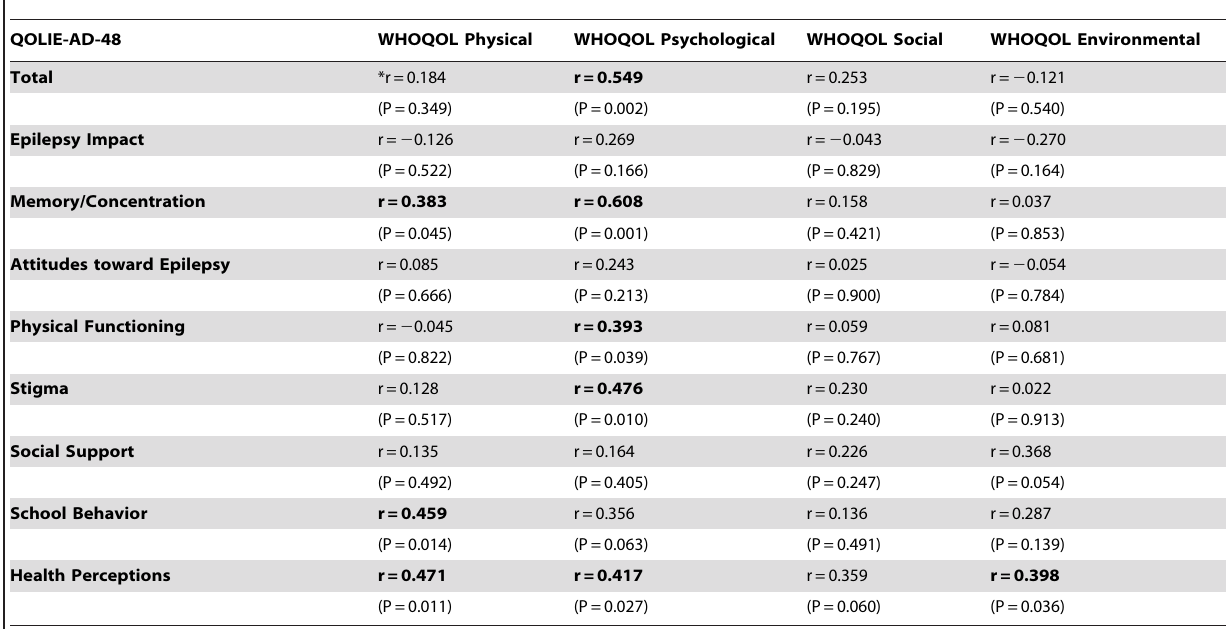
Table 6. Correlations between QOLIE-AD-48 and